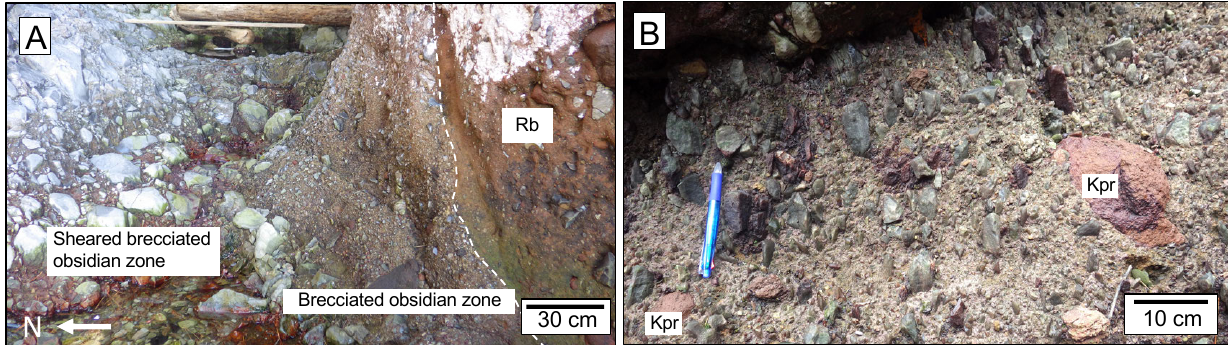
Figure 6: [A] Boundary (dotted line) between the rotated block of the Kannonzaki pyroclastic rocks (Rb) and the obsidian lithofacies. The view to the east. [B] Clasts of the reddish-colored Kannonzaki pyroclastic rocks (Kpr) are contained in the brecciated obsidian zone. The long axis of the clasts aligned nearly vertical